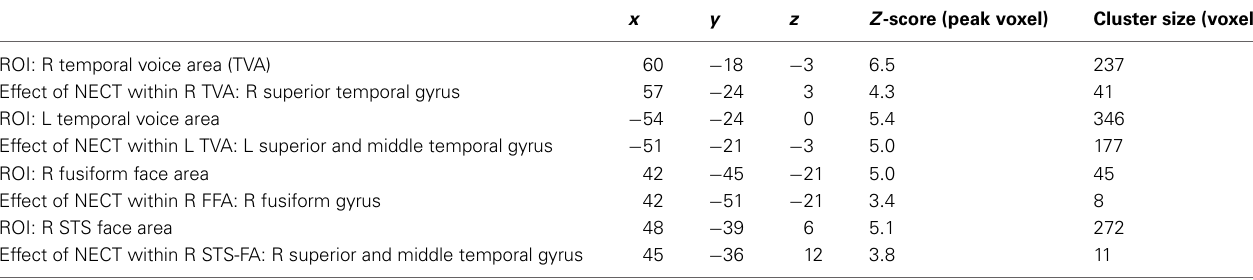
Table 2 | Voice- and face-selective brain areas with training (NECT) specific changes in their responses to non-verbal cues from voice and